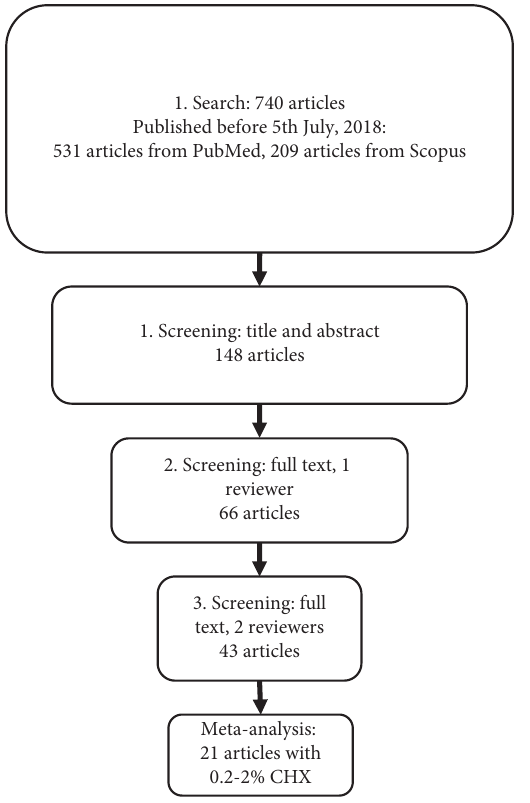
Figure 1: Protocol for the systematic literature